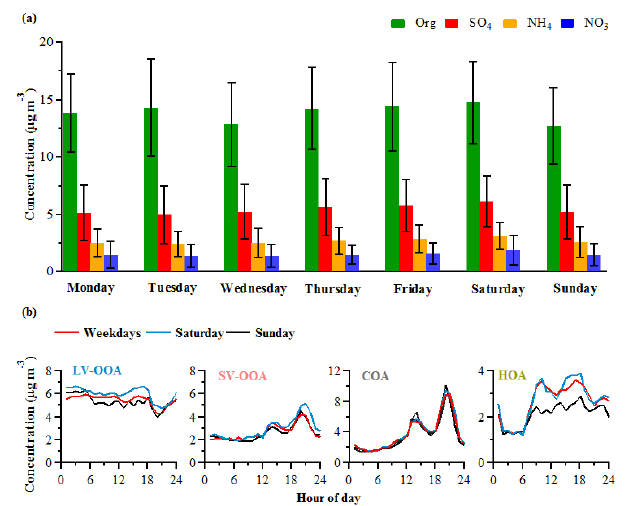
Figure 8. (a) Day-of-week variations of NR-PM 1 species (standard deviation as vertical line) and (b) average diurnal patterns of OA components for weekdays, Saturdays and